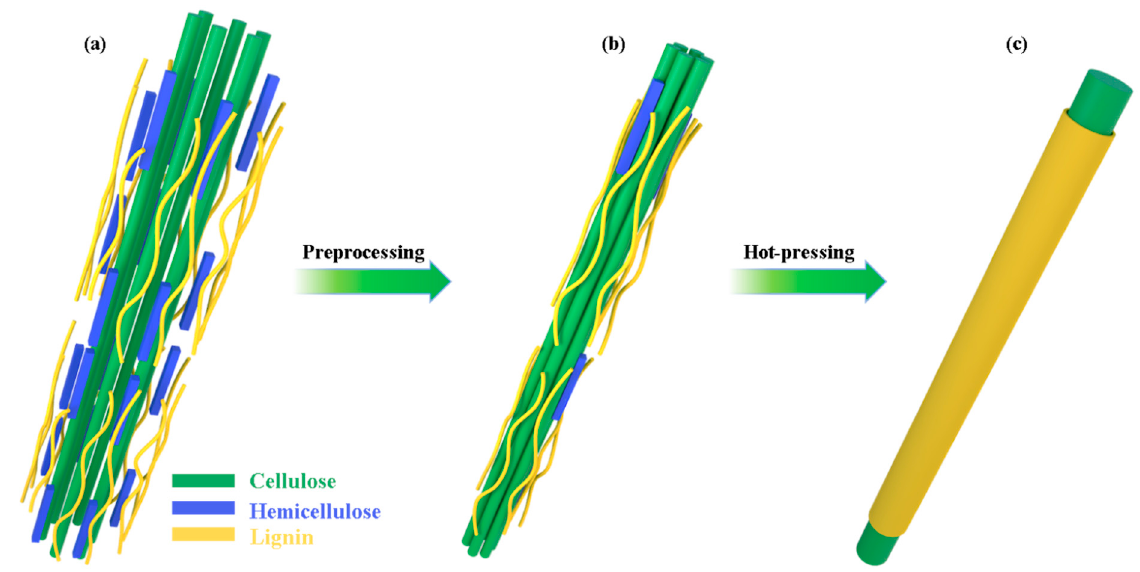
Figure 7. Bonding mechanism of ( a ) Natural bamboo. ( b ) Bamboo powder after preprocessing. ( c )